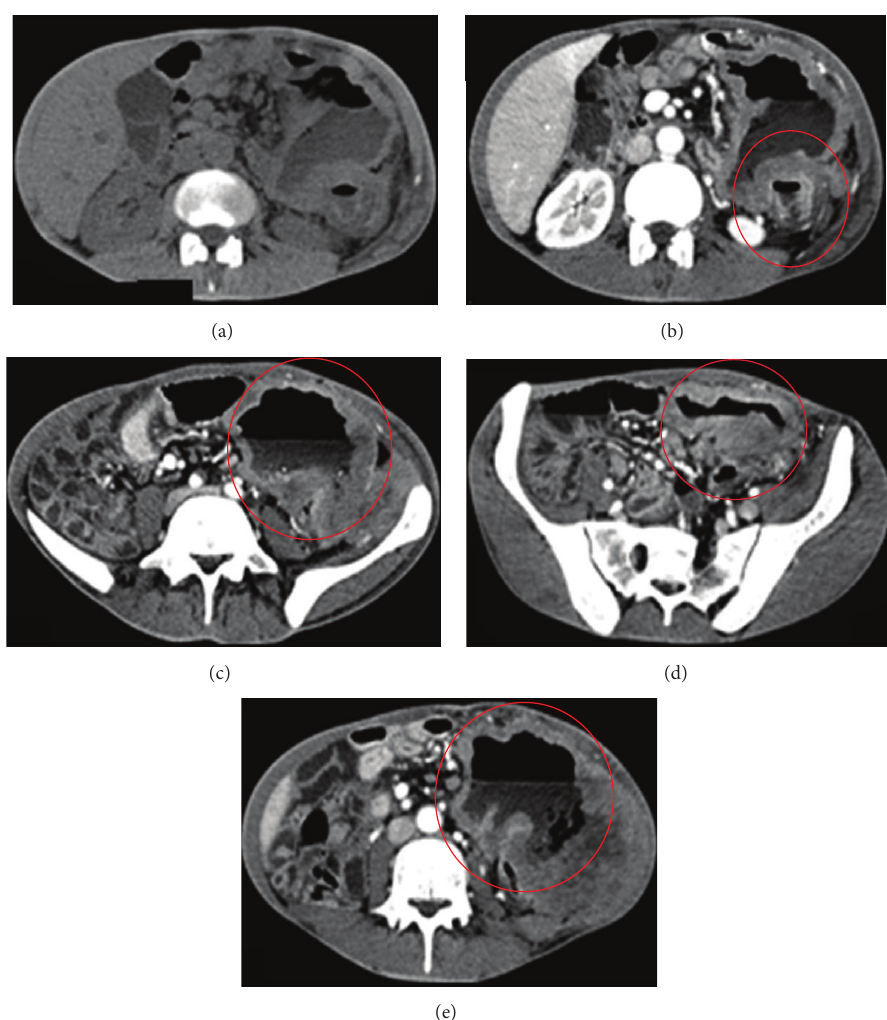
Figure 4: Aneurismatic jejunal lymphoma in a 43-year-old female. (a, b, c) Precontrastographic and postcontrastographic axial CT scan show severe circumferential wall thickening (thickening 17mm), inhomogeneously hyperdense after contrast medium injection, of a jejunal ileal loop (length: 20 cm) located in the left side and left upper quadrant (red circle). Moreover, endoluminal dilatation and air-fluid level inside and enlarged lymph nodes and the surrounding mesenteric fat can be noticed (arrowheads). (d) Infiltration of the left colonic and sigmoid bowel wall (arrow). (e) Thickened bowel walls are entwined with a newly formed lymphomatous mass of the left abdominal wall that infiltrates the left abdominal wall muscles and the superior edge of the left iliac